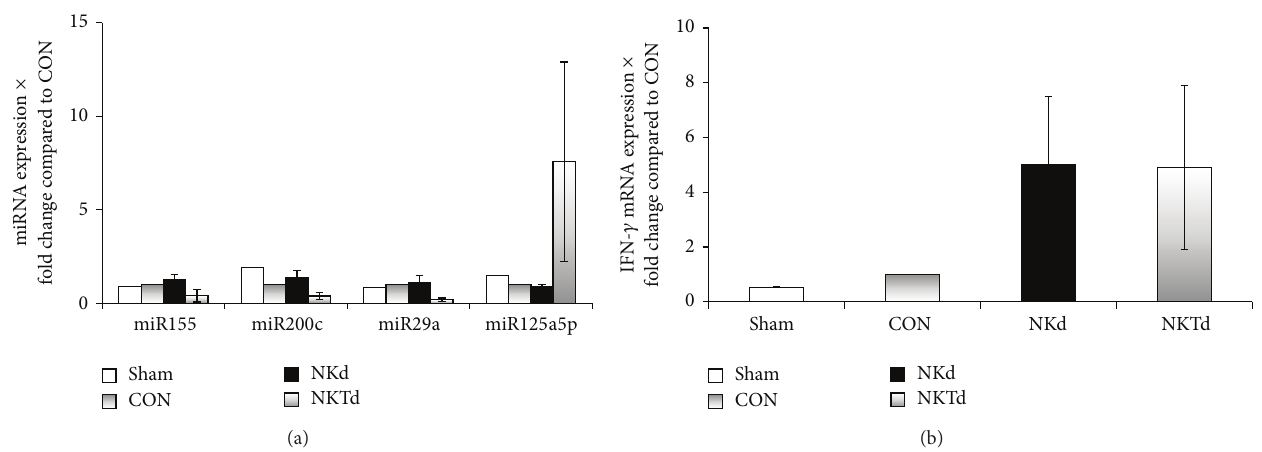
Figure 4: Expression of miRNA and of mRNA of IFN- 𝛾 in splenocytes. Splenocyte total RNA was extracted. (a) Τ he expression levels of miR-155, miR-200ca, miR-29a, and miR-125a-5p were quantified by TaqMan miRNA assays. Data was normalized to the endogenous control sno202 and fold changes of miRNA expression relative to the CON group were calculated by the ΔΔ CT method. (b) Expression of IFN- 𝛾 mRNA in splenocytes. Splenocyte total RNA was extracted and the expression level of IFN- 𝛾 was quantified by TaqMan assays. Data was normalized to the endogenous control GAPDH and fold changes of mRNA expression relative to the CON group were calculated by the ΔΔ CT method. Mice were pretreated with nonspecific IgG (CON, 𝑛 = 1 ); with anti-asialo GM1 antibody (NKd, 𝑛 = 2 ); or with anti-CD1d antibody (NKTd, 𝑛 = 2 ). Results are compared with sham-operated mice (Sham, 𝑛 = 1